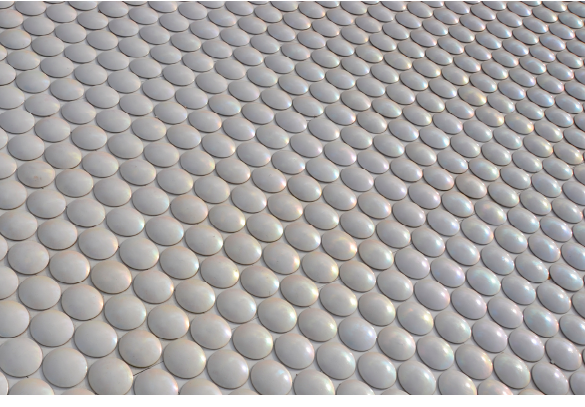
Figure 5. Ceramic tiles on the roof. Iridescent effect. Photograph: Fernando Echarri.